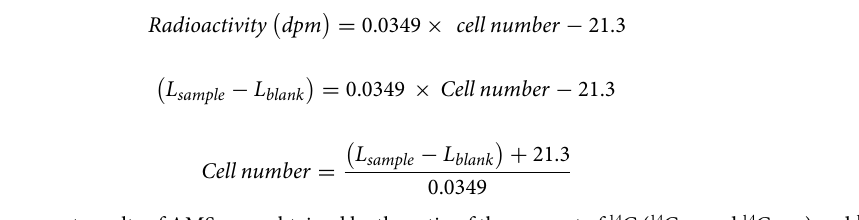
Figure 2. Analysis of biological characteristics of 14 C-labeled AD-MSCs. ( A ) Confirmation of MSC specific marker expression of unlabeled and 14 C-labeled AD-MSCs by FACS analysis. ( B ) Investigation of multipotent properties (adipogenesis, osteogenesis, chondrogenesis) of unlabeled and 14 C-labeled AD-MSCs. ( C ) Comparison of cell cycle analysis of unlabeled and 14 C-labeled AD-MSCs. Scale bar = 200 LSC was obtained using the cell number and radioactivity, Eq. (1). The cell number was calculated Eq. (2), (3). Where, L sample and L blank are the radioactivity (dpm) of the sample and pre-dose organ, respectively